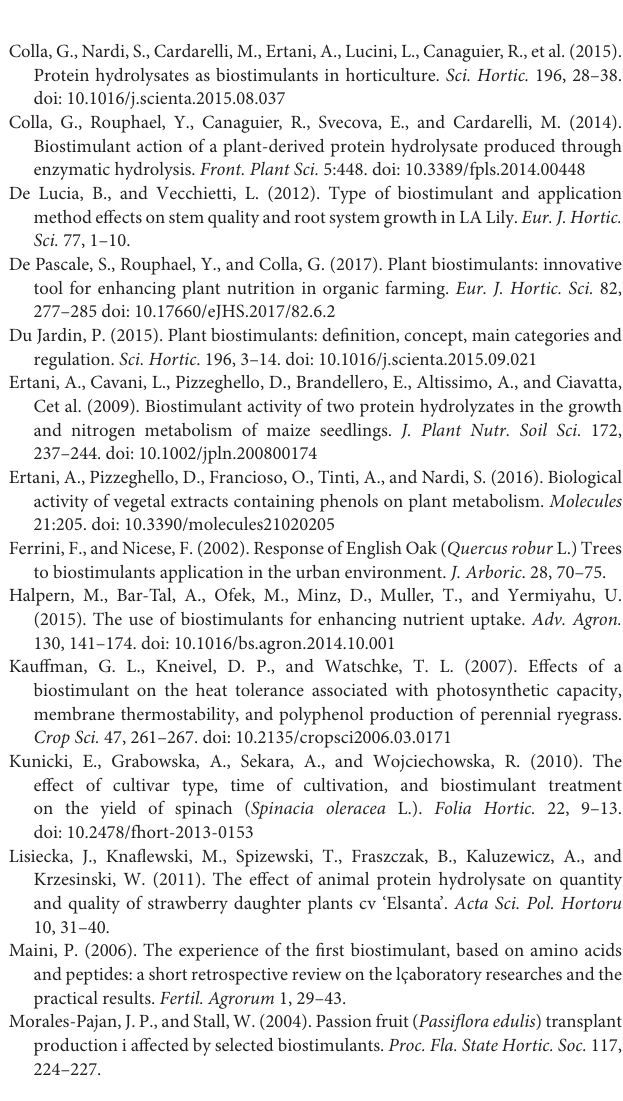
Table S5 | The effects of the interaction between biostimulant dose application methods and cultivar on snapdragon plants characteristics: total root length, root diameter, root volume, root tips, root crossings, and root forks. Table S6 | The effects of the interaction between biostimulant dose and cultivar on snapdragon plants characteristics: projected root area (cm 2 /plant), total